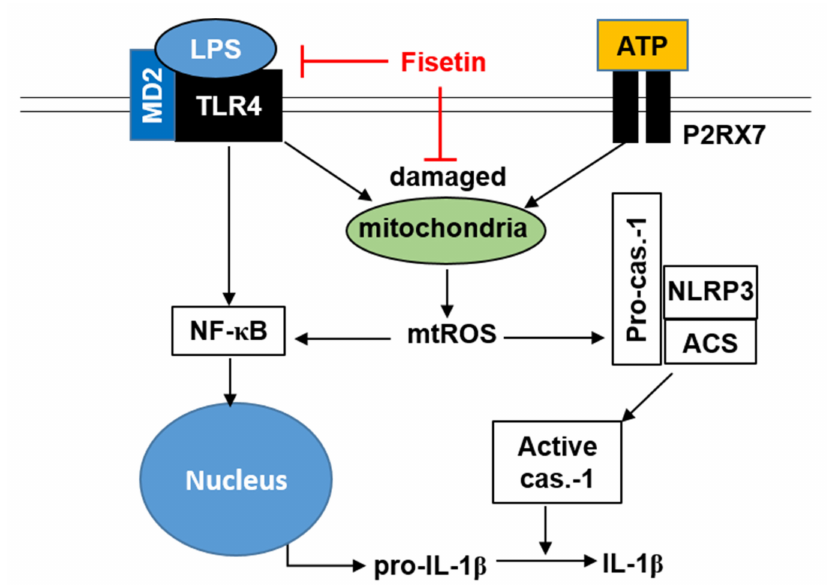
Figure 8. Schematic representation of the inhibitory effect of fisetin on the NLRP3 inflammasome in BV2 microglial cells. Fisetin inhibits the formation of the NLRP3 inflammasome primarily via two signaling pathways. In the first signaling pathway, fisetin competitively antagonizes the recogni- tion of LPS by the TLR4/MD2 complex by binding to SER438 of TLR4 and occluding the hydrophobic pocket of MD2. This inhibits the canonical NF- κ B signaling pathway, which consequently suppresses the transcription of IL-1 β . In the second pathway, fisetin downregulates the production of mtROS by promoting the elimination of damaged mitochondria in a p62-dependent manner. The inhibition of mtROS production is associated with a decrease in the formation of the NLRP3 inflammasome, which subsequently inhibits the caspase-1-mediated cleavage of pro-IL-1 β to active IL-1 β . P2RX7, P2X purinoceptor